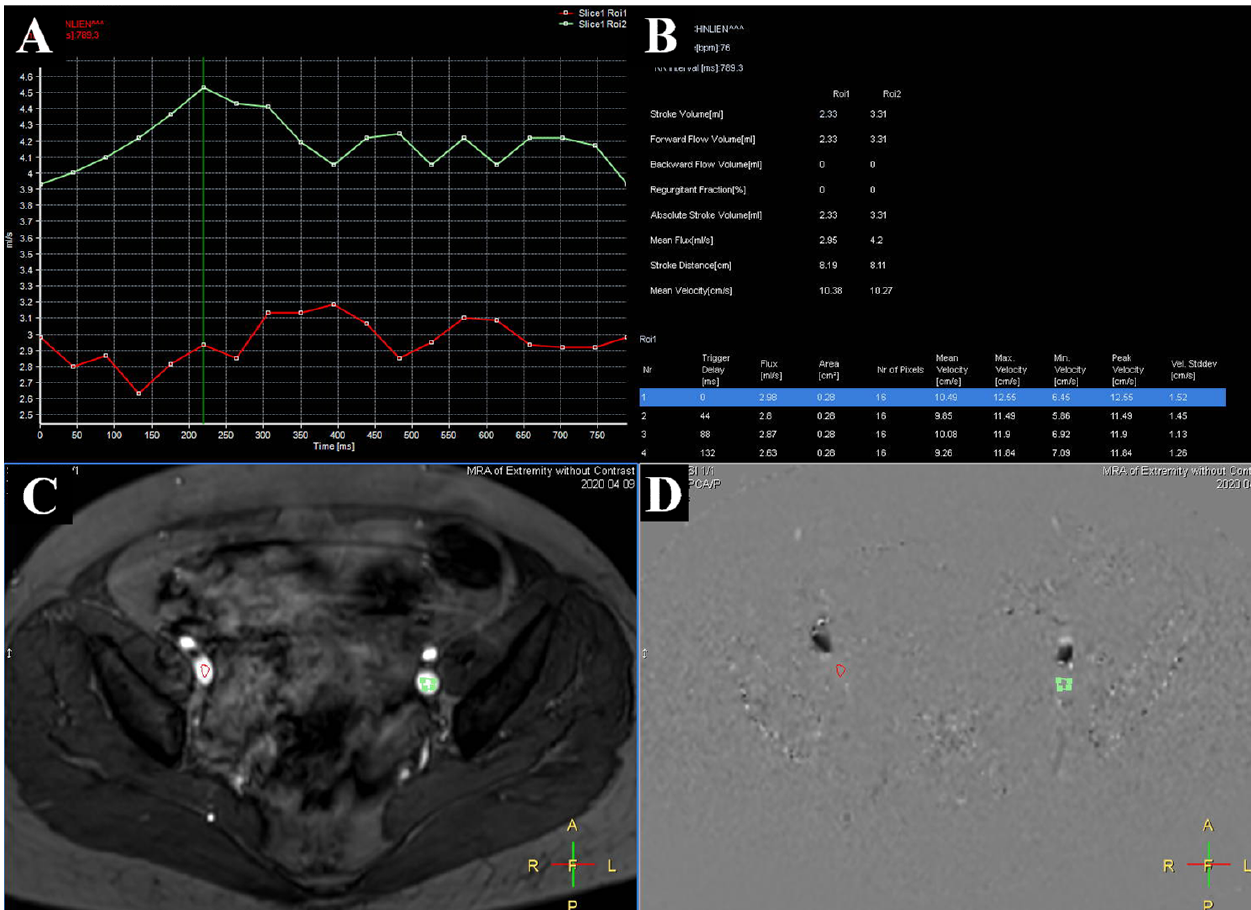
Figure 1. QFlow scanning through TRANCE-MRI. ( A ) Two external iliac veins with the flow sequence by time. ( B ) QFlow parameters with different trigger delays. ( C ) Areas of interest in both external iliac veins. ( D ) Image obtained during data acquisition.